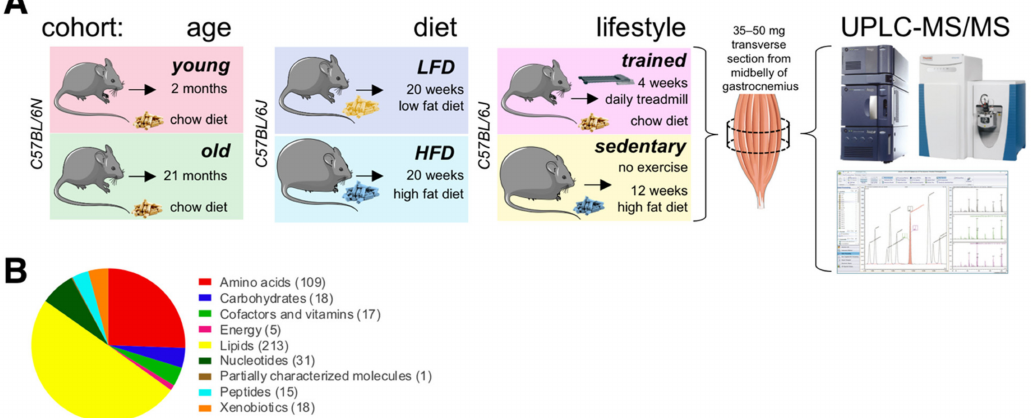
Figure 1. The skeletal muscle metabolome in relation to age, diet, and lifestyle. ( A ) Scheme of experimental design. Figure elements modified from SMART (Servier Medical Art), licensed under a Creative Common Attribution 3.0 Generic License. http://smart.servier.com/ accessed on 9 June 2021. ( B ) Classification of 427 detected metabolites. The number of metabolites per class is given in